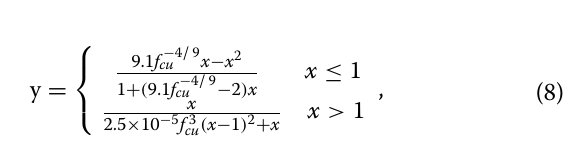
Fig. 14 Reduction factor of concrete compressive